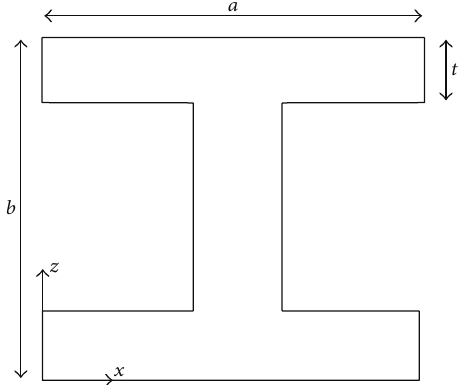
Figure 12: Cross-section of the I-shaped